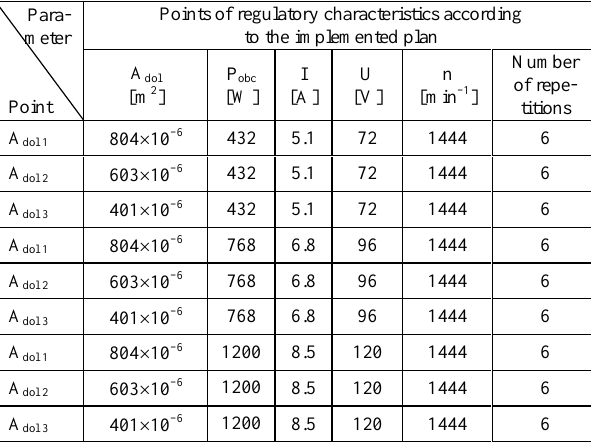
Table 2. Engine test plan to determine the significance of the effect of its active cross-sectional area of the Adol intake air channel on the specific enthalpy of the exhaust gas stream within one h spal working cycle Para-